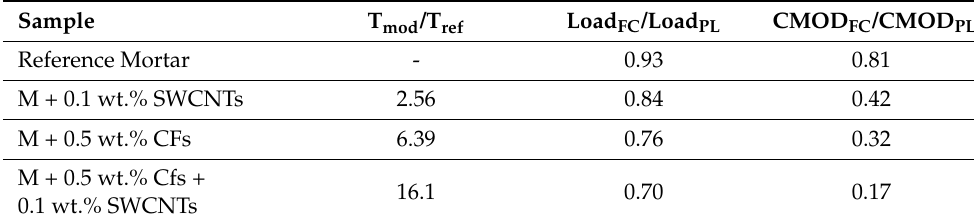
Table 2. First crack load and toughness values of reference mortar and nano-, micro-, and hybrid- reinforced cement mortars with SWCNTs and/or